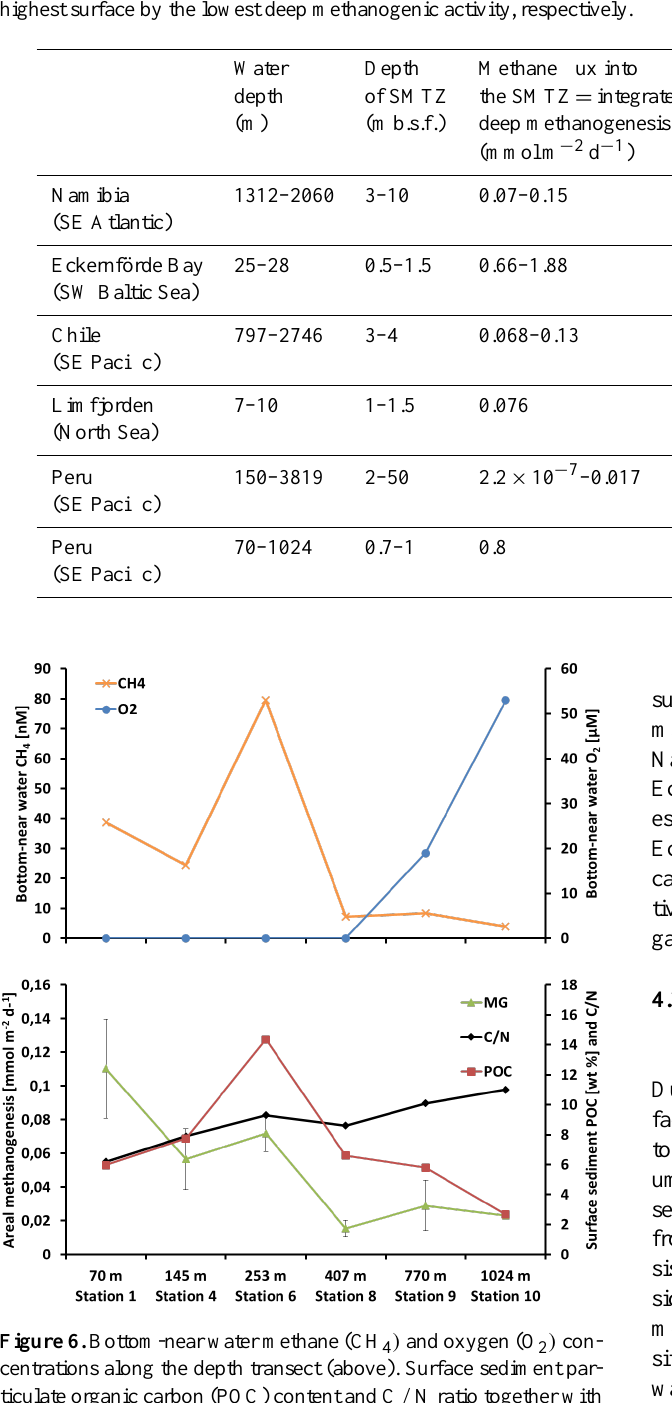
Table 2. Comparison of deep methanogenesis in organic-rich sediments from different regions with surface methanogenesis (0.02– 0.1mmolm − 2 d − 1 ) determined in the present study. The ratio range was achieved by dividing the lowest surface by the highest deep and the highest surface by the lowest deep methanogenic activity, respectively.